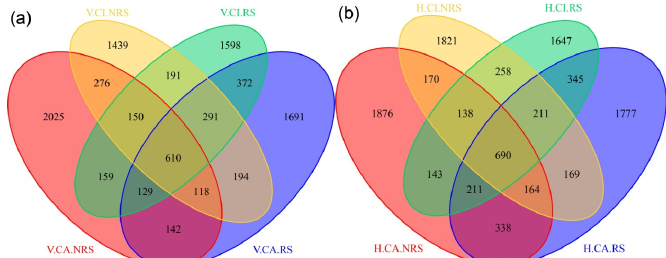
Figure 4. Venn diagram showing the unique and shared OTUs (0.03 phylogenetic distance). Venn diagram for four sampling zones in VSFCW (a) and four sampling zones HSFCW (b) . The calculation of the Venn diagram was based on results of three duplicates in each zone. The samples numbers were shown in Figure 2.